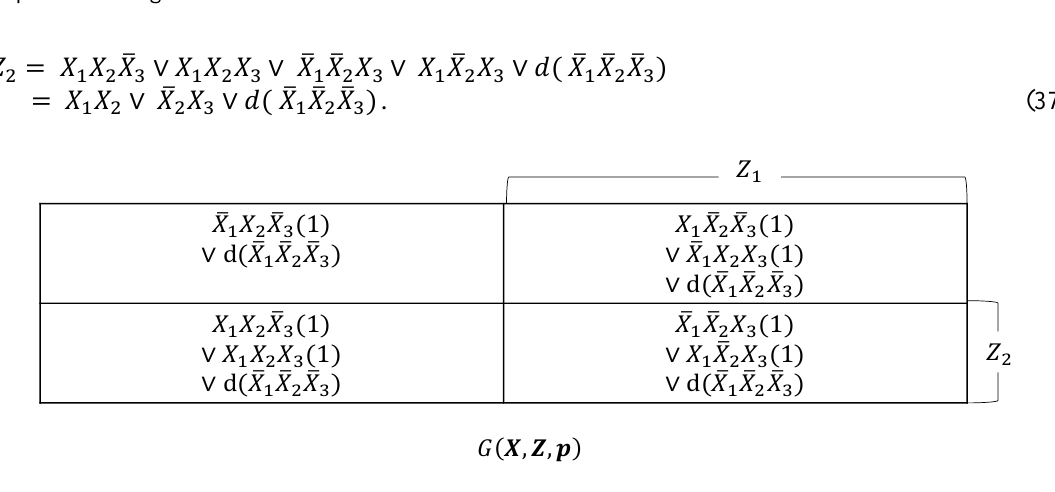
Fig. 10. The auxiliary function for Example